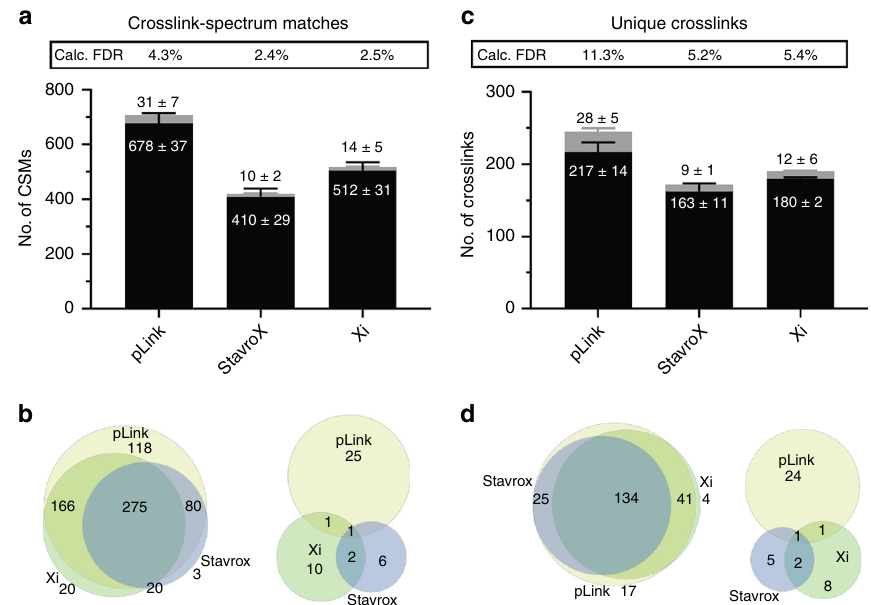
Fig. 2 Comparison of pLink, StavroX and Xi performance based on the crosslinked peptide library. a number of CSMs that correspond to correct (black) and incorrect (grey) crosslinks identi fi ed by three search algorithms with incorporated FDR estimation. Results were fi ltered to an estimated 5% CSM-FDR, and the calculated FDR is given for each algorithm. b Agreement of correct (left) and incorrect CSMs (right) between pLink, StavroX and Xi for one technical repeat. c Number of correct unique crosslinks (black) and incorrect crosslinks (grey) identi fi ed with an estimated CSM-FDR of 5%. d Overlap of correct (left) and incorrect crosslinks (right) for one technical repeat. Values for fi gures a and c are given in Supplementary Tables 2 and 3, and average values ± standard deviation are shown on the stacked bar plots (rounded to the closest whole number). All results fi les can be found in Supplementary Data 1. Error bars correspond to the standard deviation between technical replicates ( n =